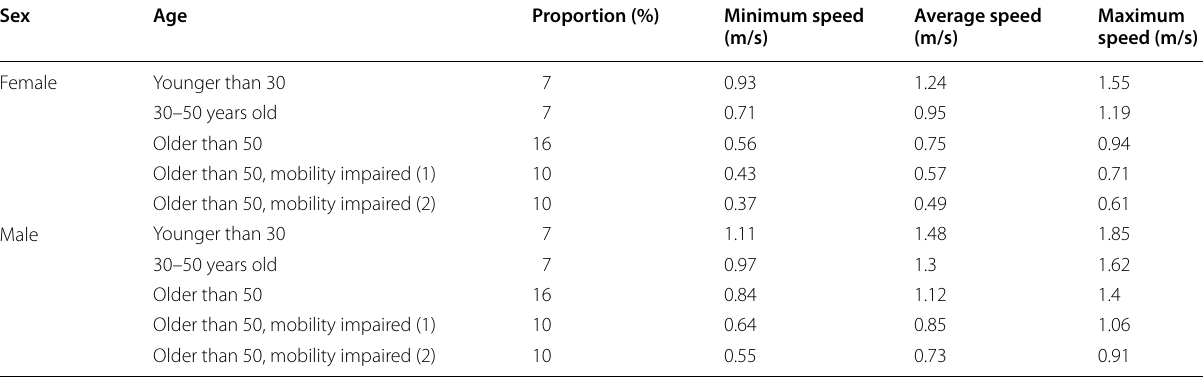
Table 3 Passenger age-speed distribution